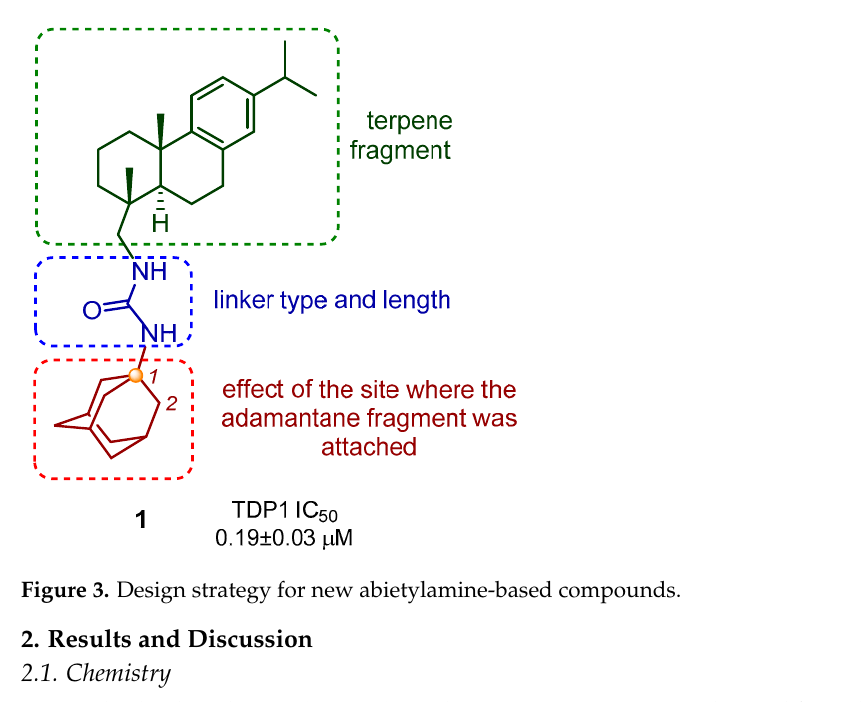
Figure 2. Structures of natural-based TDP1 inhibitors and their IC 50 values.